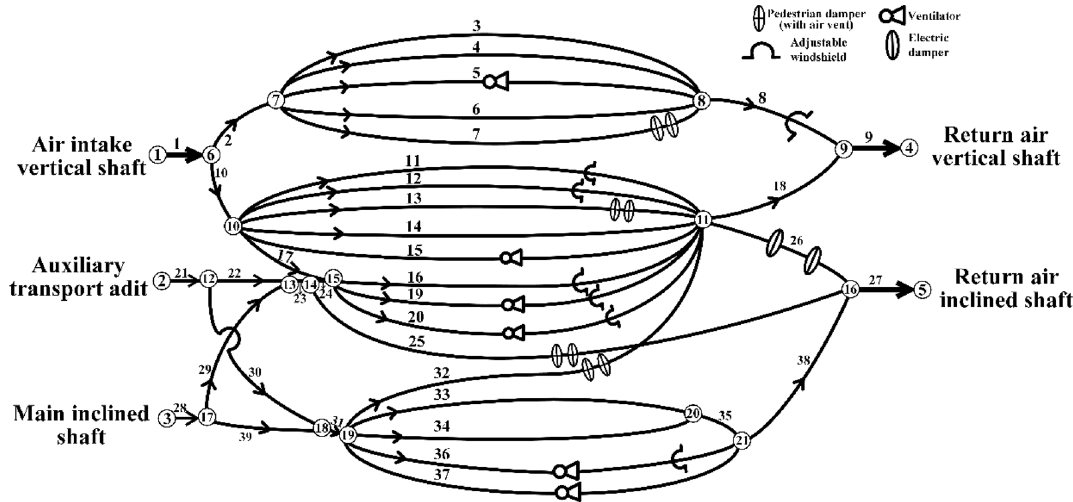
Figure 2. Ventilation network diagram of the Burtai coal mine.